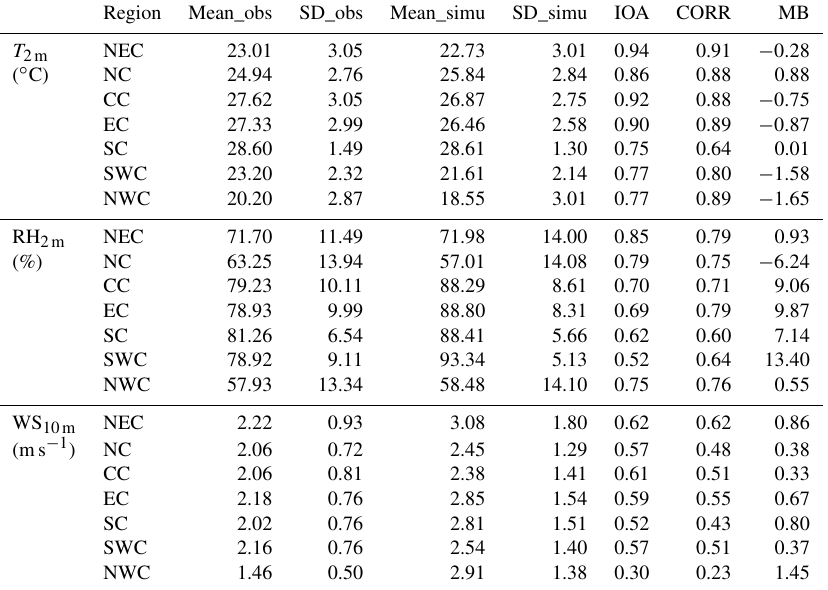
Table 4. Evaluation results of temperature at 2m ( T 2m ), relative humidity at 2m (RH 2m ), and wind speed at 10m (WS 10m ) in seven major geographic regions from the implemented model. NEC is northeast China, NC is north China, CC is central China, EC is east China, SC is south China, SWC indicates southwest China, and NWC is northwest China. Mean_obs (Mean_simu) is the mean value of observations (model simulations); SD_obs (SD_simu) is the standard deviation of the observations (model simulations); IOA is the index of agreement; CORR is the correlation coefficient; MB is the mean